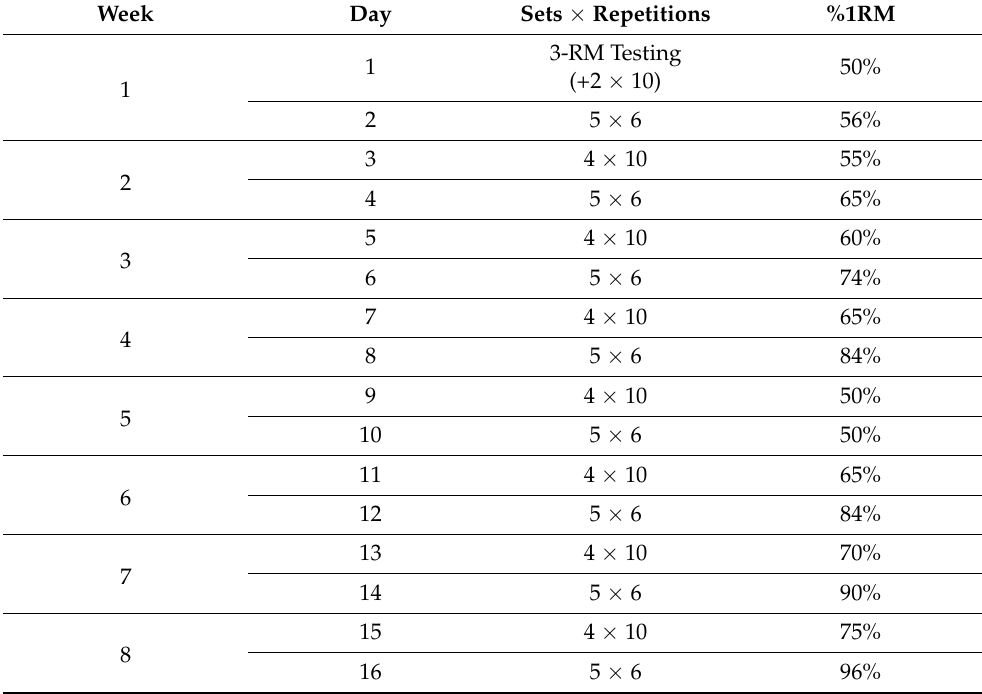
Table 4. Resistance exercise training